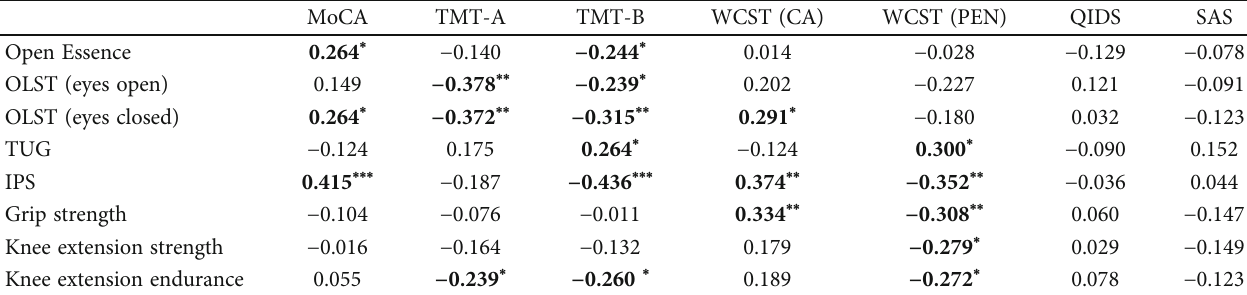
Table 4: Correlation between cognitive function test and olfactory identi fi cation, balance capability, and muscle strength in the type 2 diabetes group.